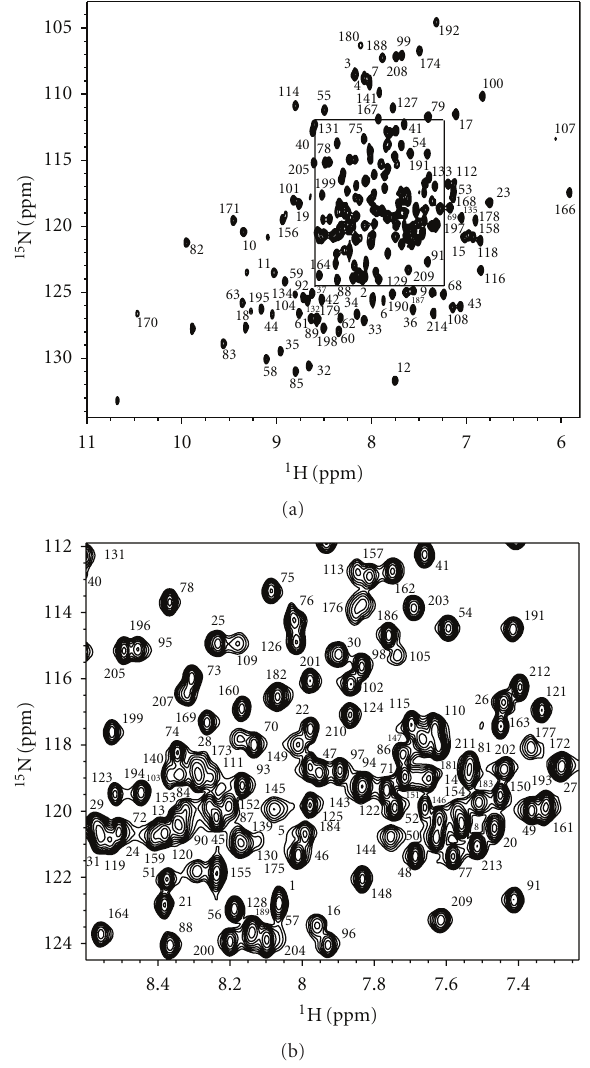
Figure 3: Two-dimensional 1 H- 15 N correlation spectrum of Pfu RPP30. Residue numbers indicate assigned backbone amide reso- nances. The boxed region of the full spectrum (a) is expanded (b) for